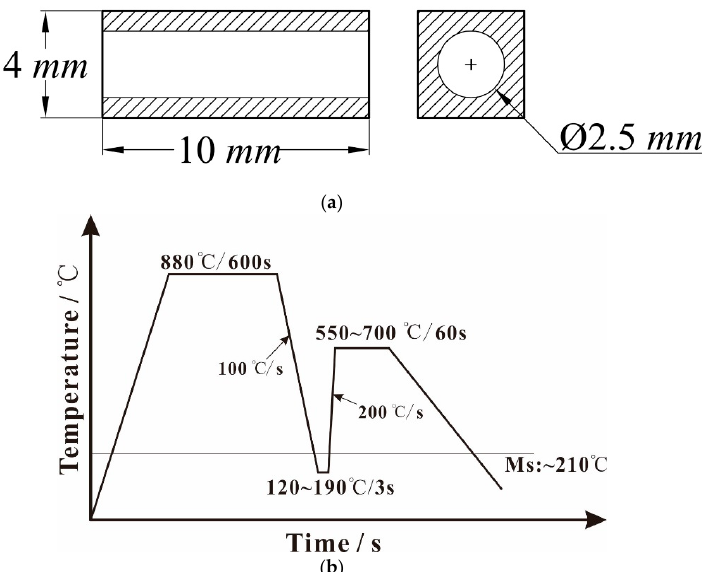
Figure 1. ( a ) Specimen size for the heat treatments on the dilatometer; ( b ) heat treatment process curve of high-carbon steel.